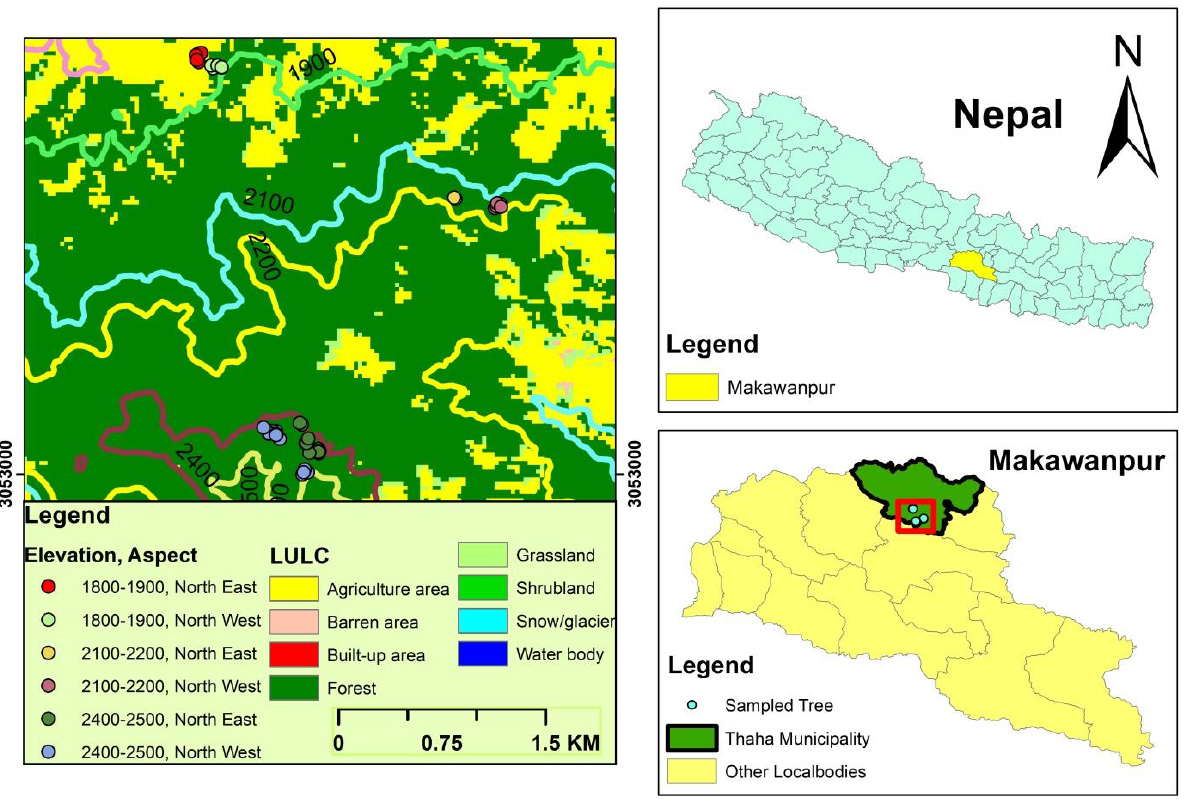
Figure 1. Map of the study area and sampling sites along the elevation and aspect gradients in the Makwanpur district in Nepal.